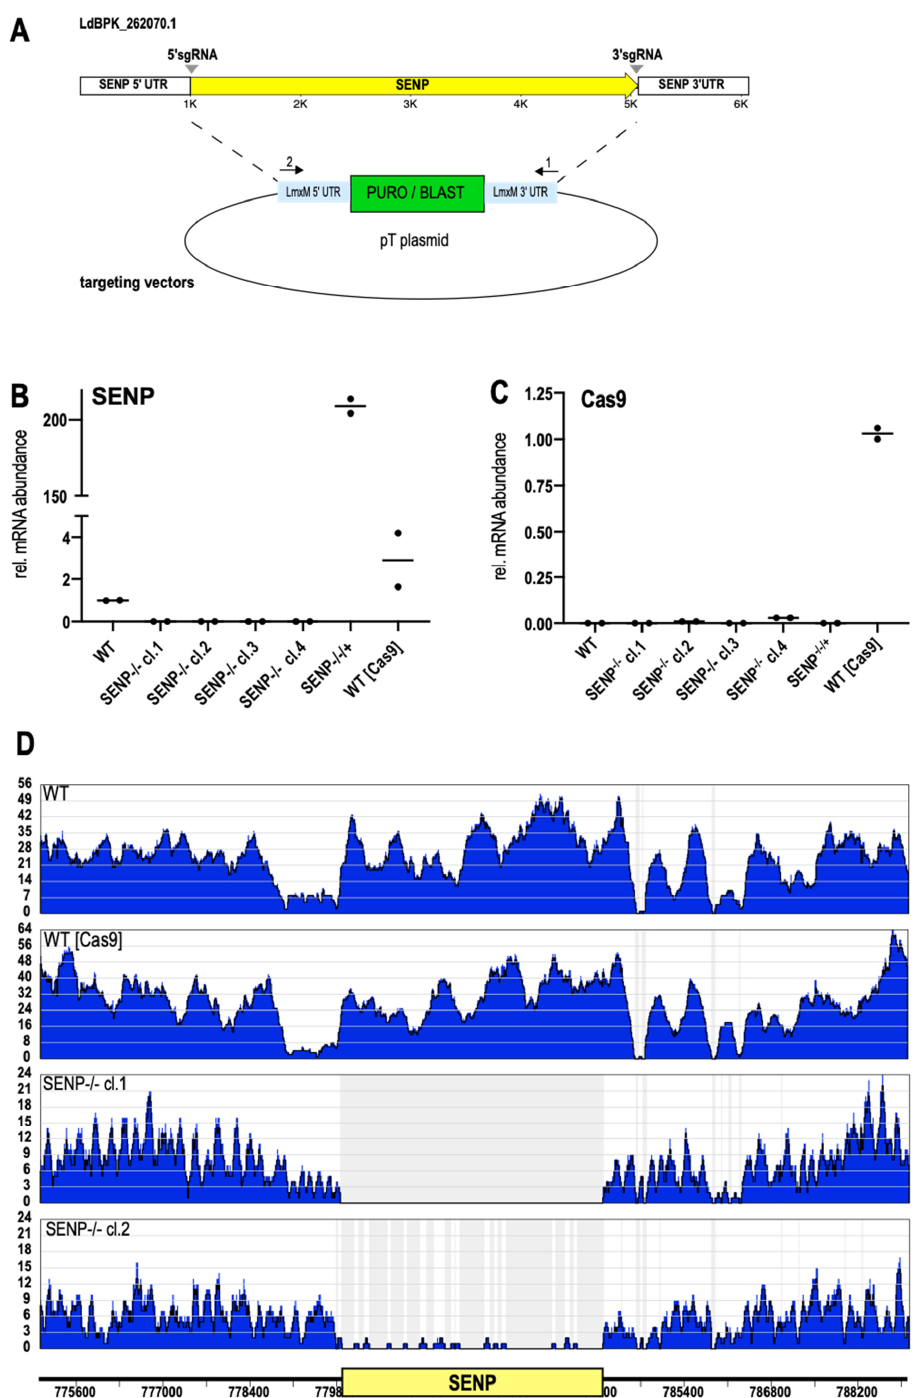
Figure 3. Replacement of SENP. ( A ) Schematic representation of LdBPK_262070 replacement using the CRISPR / Cas9 technology. SUMO -targeting sgRNAs (grey arrowheads) and replacement cassettes were PCR-amplified and transfected into L. donovani (Cas9 / T7RNAP). ( B , C ) RT-qPCR of RNA from L. donovani ( B ) SENP-specific RT-qPCR. ( C ) Cas9-specific RT-qPCR. n = 2. ( D ) Whole genome sequencing of L. donovani wild type (WT), L. donovani (Cas9 / T7RNAP), SENP − / − cl.1 and SENP − / − cl.2. Sequence